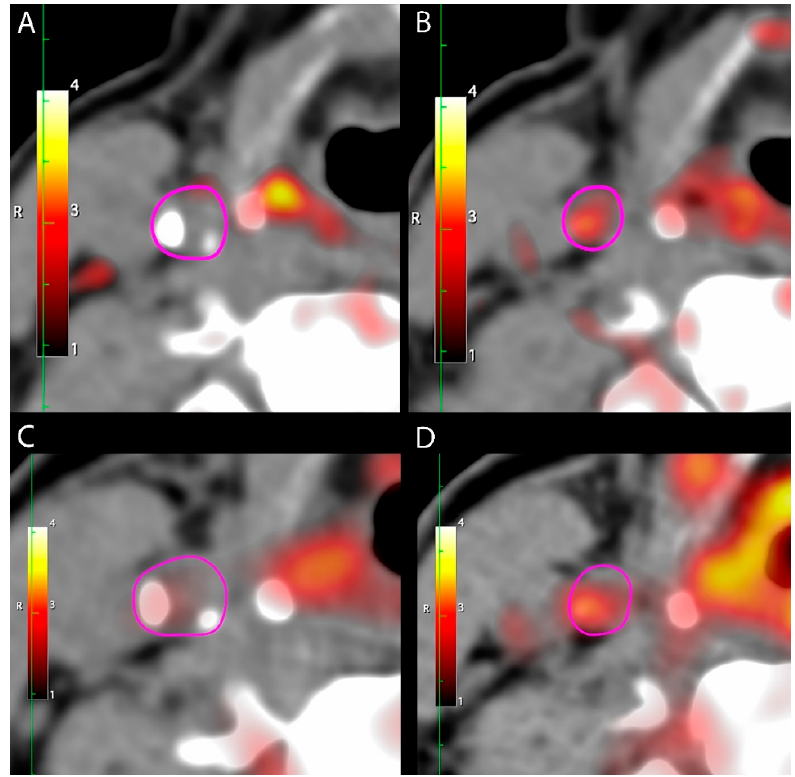
Figure 1. PET/CT images at baseline with high and low uptake of [ 64 Cu]DOTATATE. Representative baseline axial images showing the carotid artery outlined in pink. ( A ). An axial slice with calcifications and low uptake of [ 64 Cu]DOTATATE (SUV mean = 0.9). ( B ) An axial slice with minimal calcifications and high uptake of [ 64 Cu]DOTATATE (SUV mean = 1.4). ( C , D ) [ 18 F]FDG uptake in the same locations for comparison.